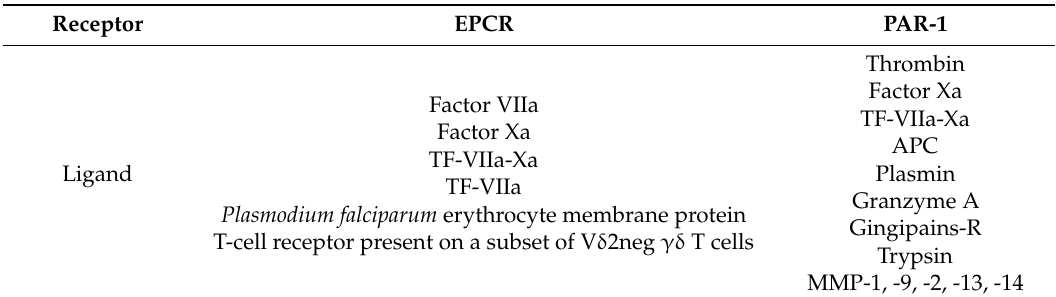
Table 1. Ligands leading to EPCR (endothelial protein C receptor) or PAR-1 (protease-activated receptor-1) activation